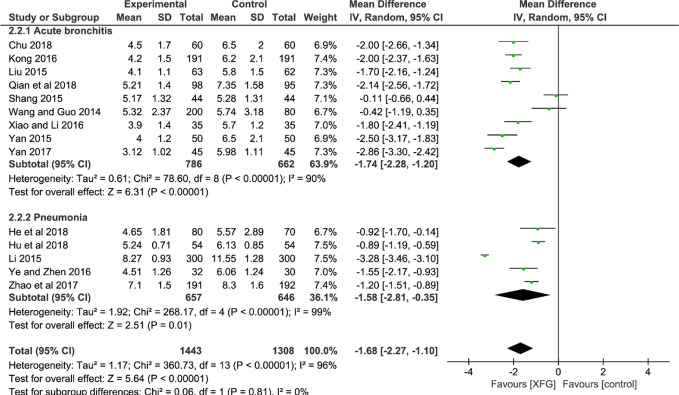
Forest plot and subgroup analysis of the RTR.